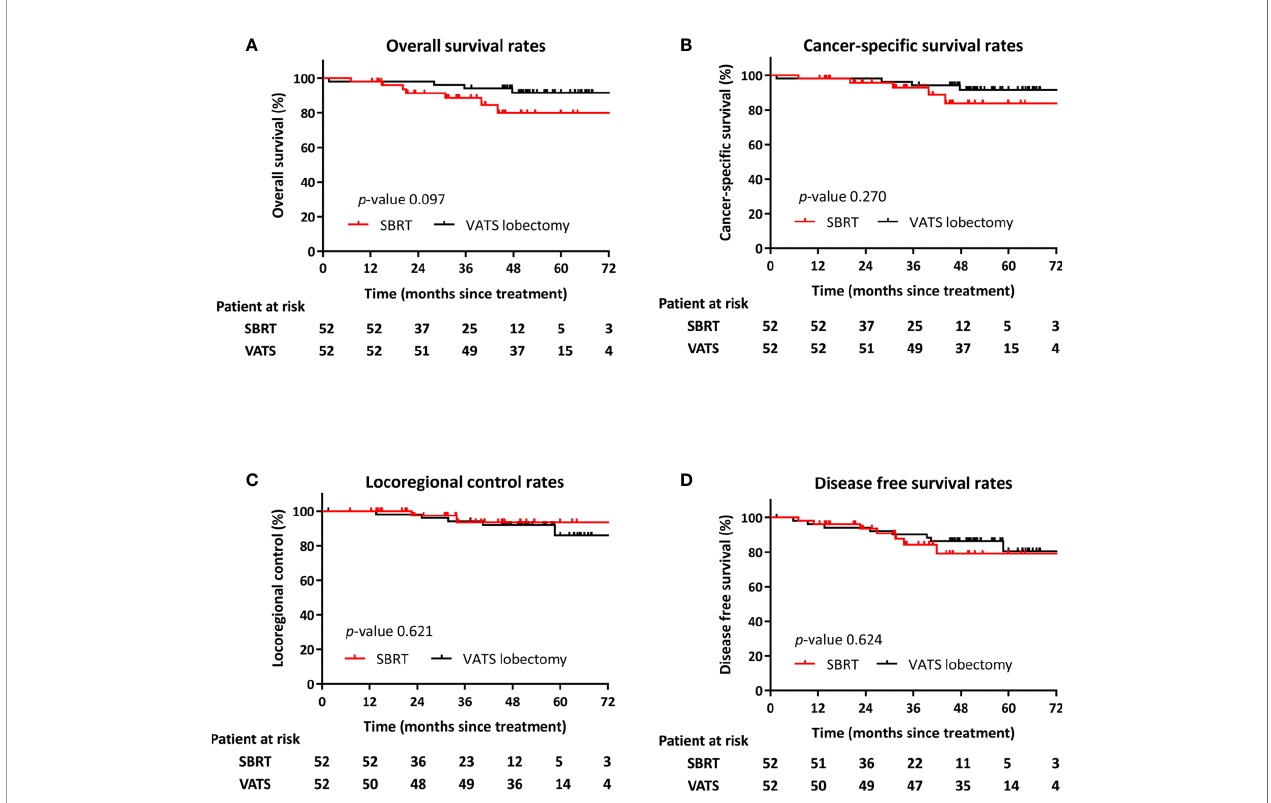
FIGURE 2 | Kaplan – Meier curves following propensity score-matching for overall survival (A) , cancer-speci fi c survival (B) , locoregional control (C) , and progression- free survival (D) of patients after VATS lobectomy or SBRT.